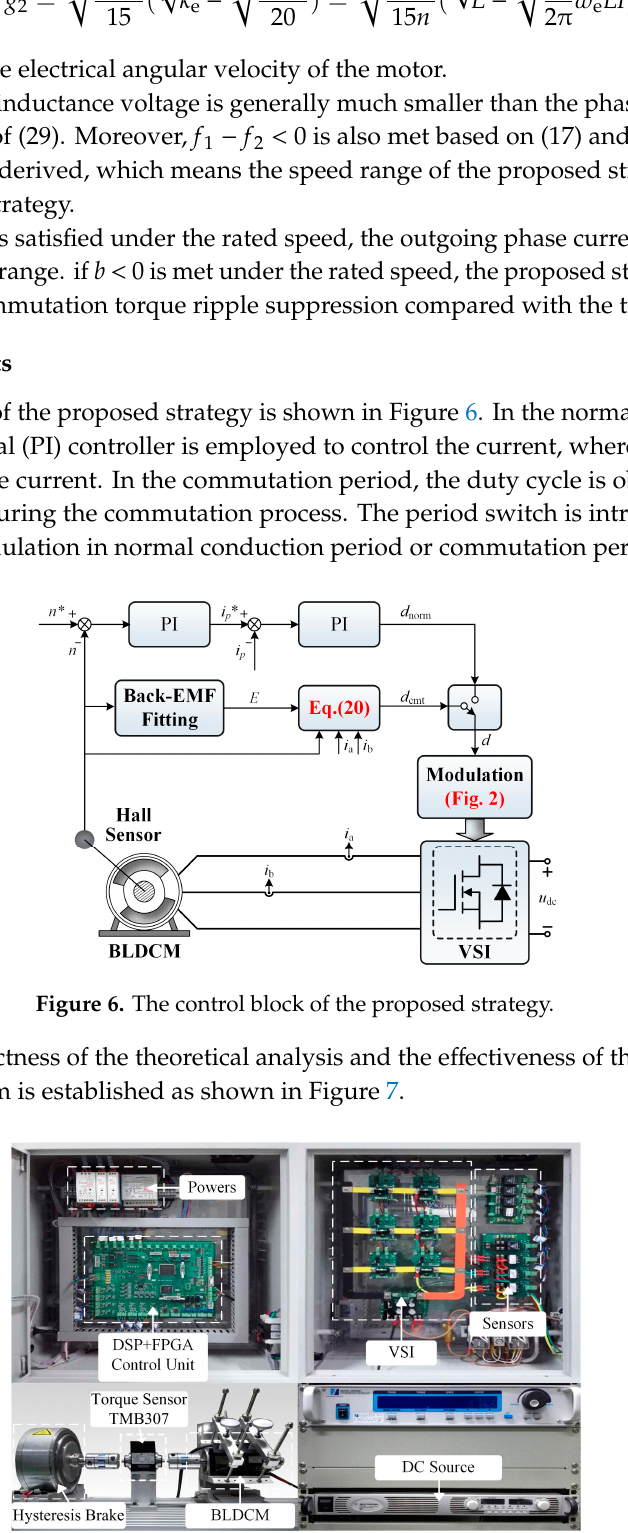
Figure 7. Experimental system.